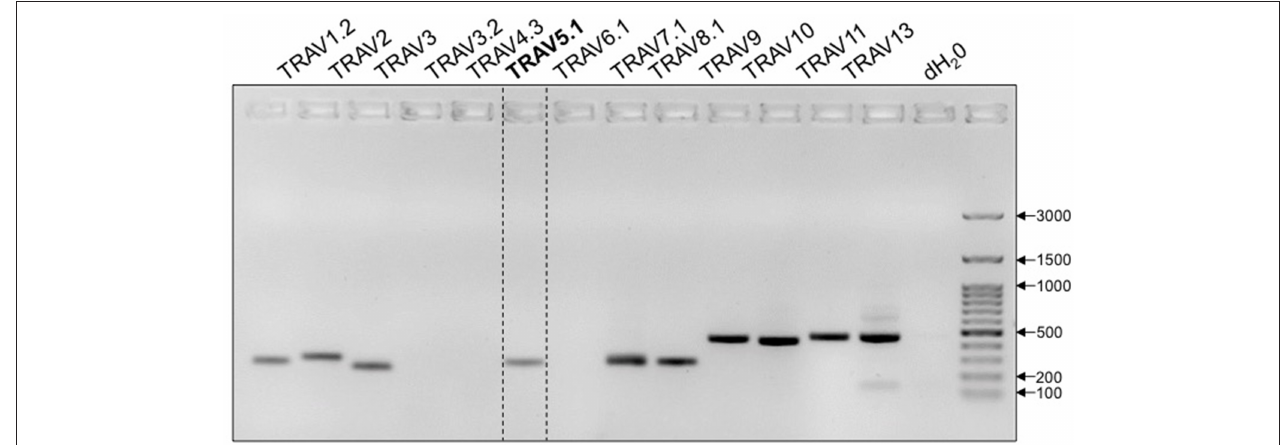
FIGURE 1 | 1C6 Tg T cells are promiscuous in their expression of endogenous TcR α . Purified splenic 1C6 CD8 + T cells were assessed for the presence of specific TcR α DNA by PCR. Transgenically encoded V α 5.1 bracketed by dotted lines. Representative of three